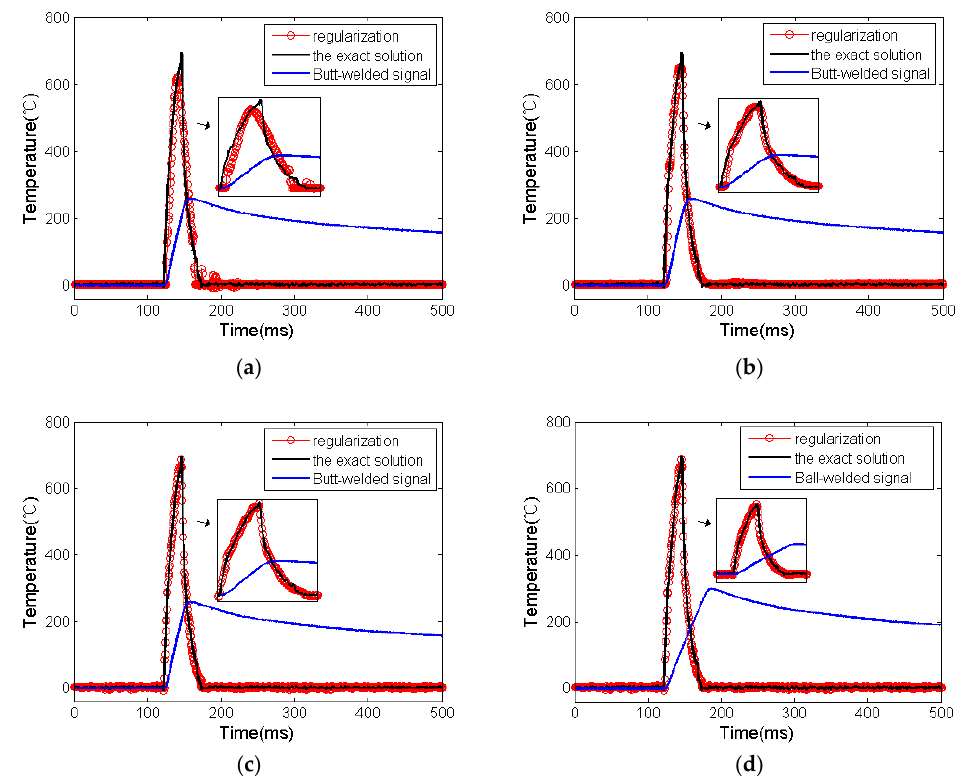
Figure 7. Calculation results of two junction structures: ( a ) butt-welded signal, exact solution and regular solution when 𝜎 = 0.0001 ， 𝑚 = 2 ; ( b ) butt-welded signal, exact solution and regular solution when 𝜎 = 0.0001 ， 𝑚 = 5 ; ( c ) butt-welded signal, exact solution and regular solution when 𝜎 = 0.0001 ， 𝑚 = 8 ; ( d ) ball-welded signal, exact solution and regular solution when 𝜎 = 0.0001 ， 𝑚 = 8 .